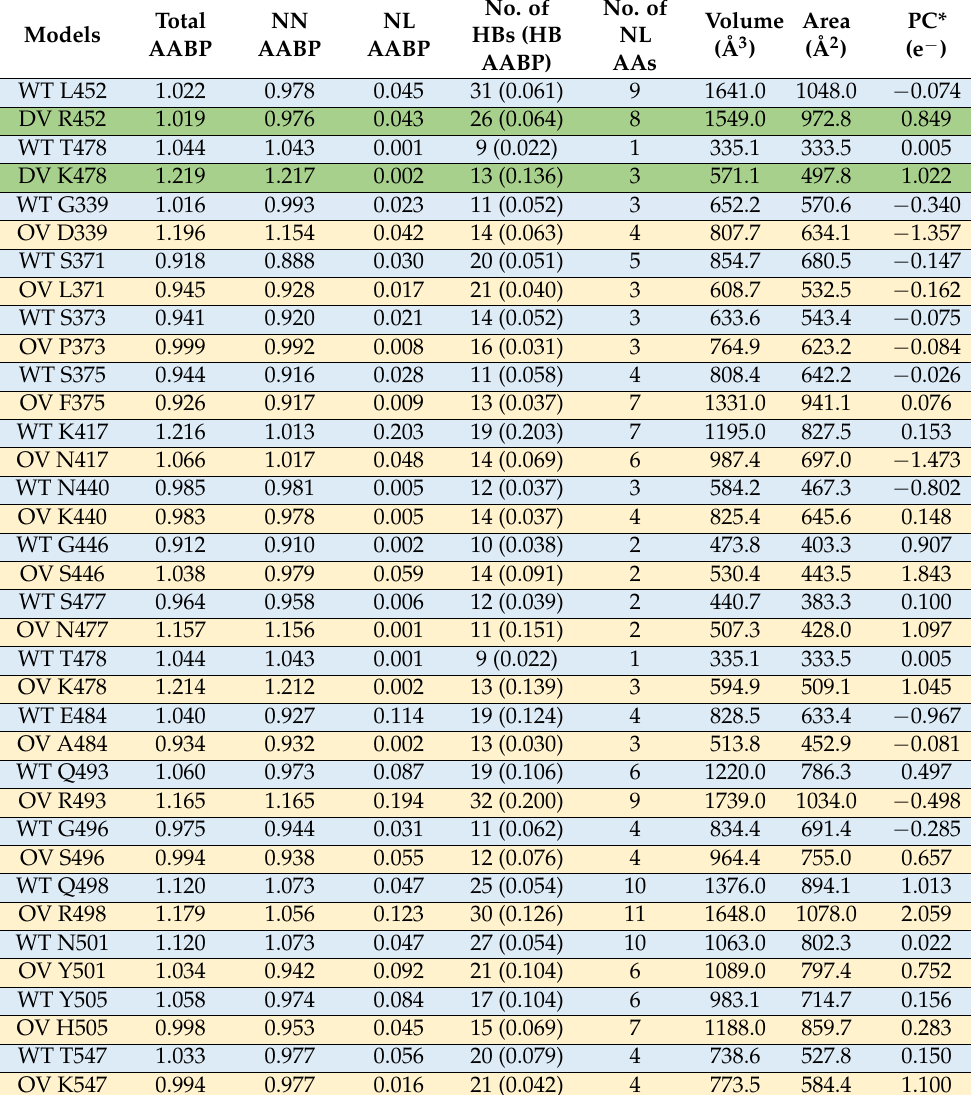
Table 2. Comparison of AABP units between wild type (WT), top 2 mutations for Delta variant (DV) and 16 mutations for Omicron variant (OV) BA.1 in the RBD-SD1 domain from reference [31]. AABP is in unit of electrons (e −